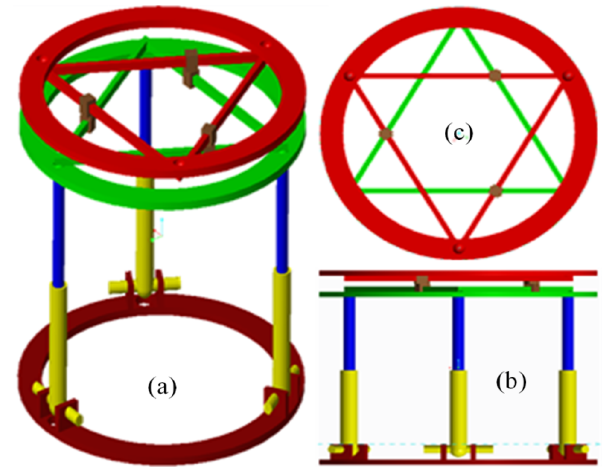
Figure 4. Schematic of the basic concept and kinematic represen- tation of the mechanical